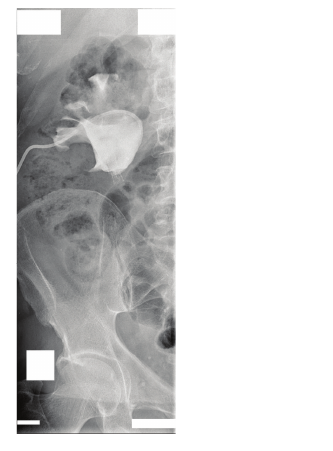
Figure 4: Image from the semirigid ureterorenoscopy with laser lithotripsy